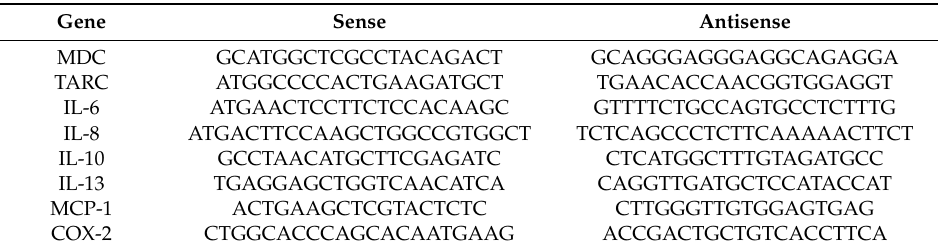
Table 3. PCR primer used in this